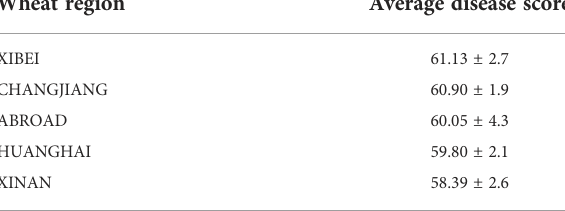
TABLE 3 Sharp eyespot disease scores of different wheat regions. Wheat region